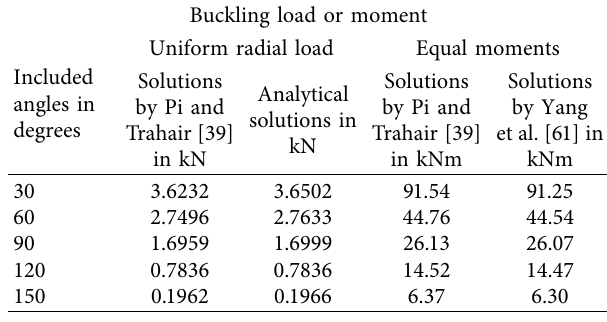
Table 1: Comparison of results for arches [39, 61].